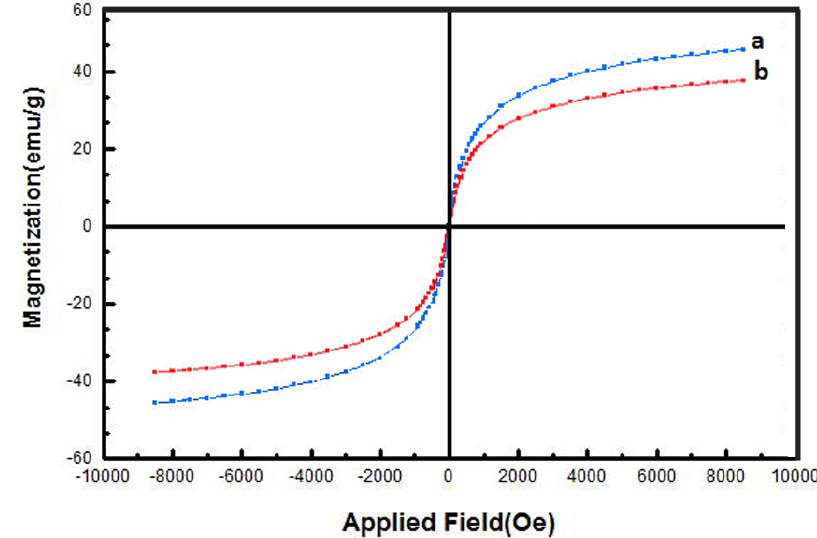
@ SiO O NPs 3 4 2